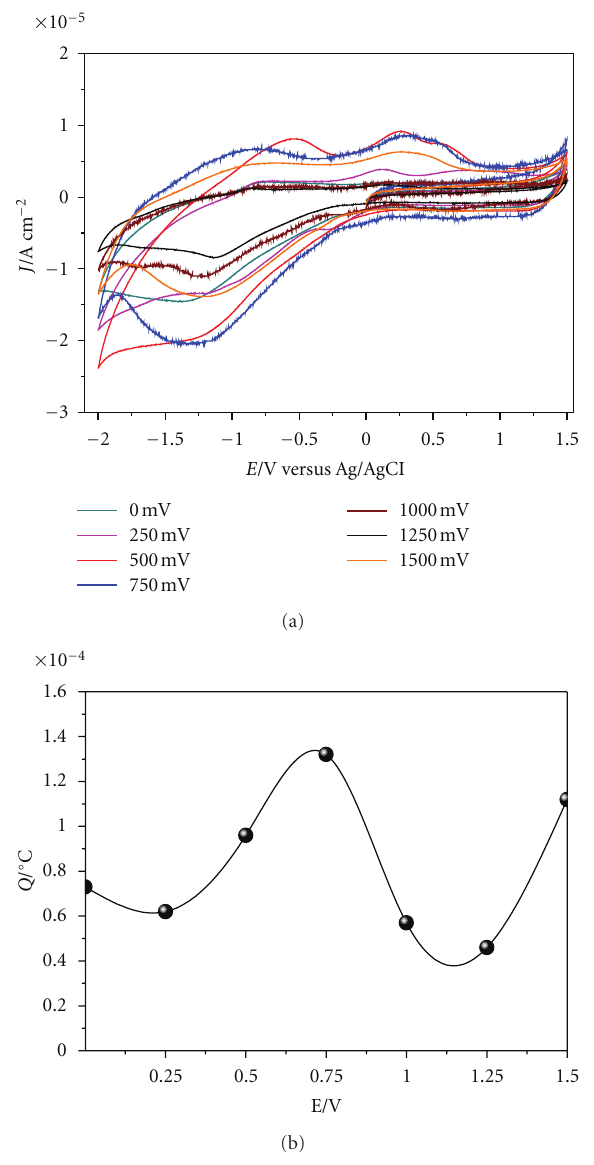
Figure 7: Profiles obtained by (a) voltamperometry of the nan- otubes electrochemically modified with Ti as a function of the initial polarization, and (b) amount of load corresponding to nanotubes modified with Ti as a function of the initial